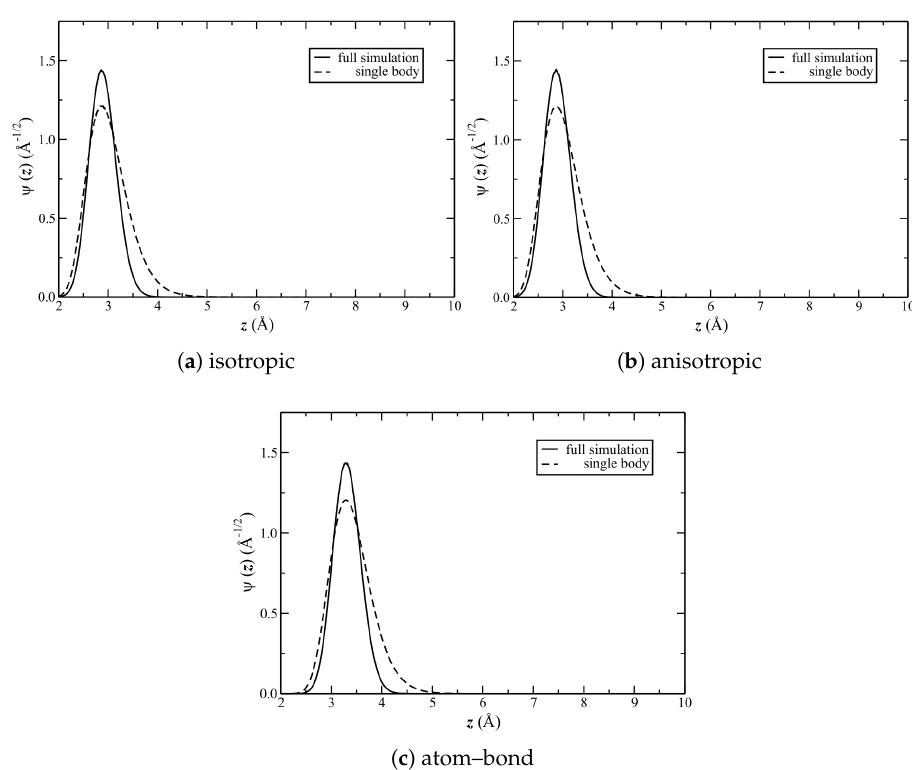
Figure 8. ψ ( z ) (from Equation (5)). Both single-body and full-simulation results are